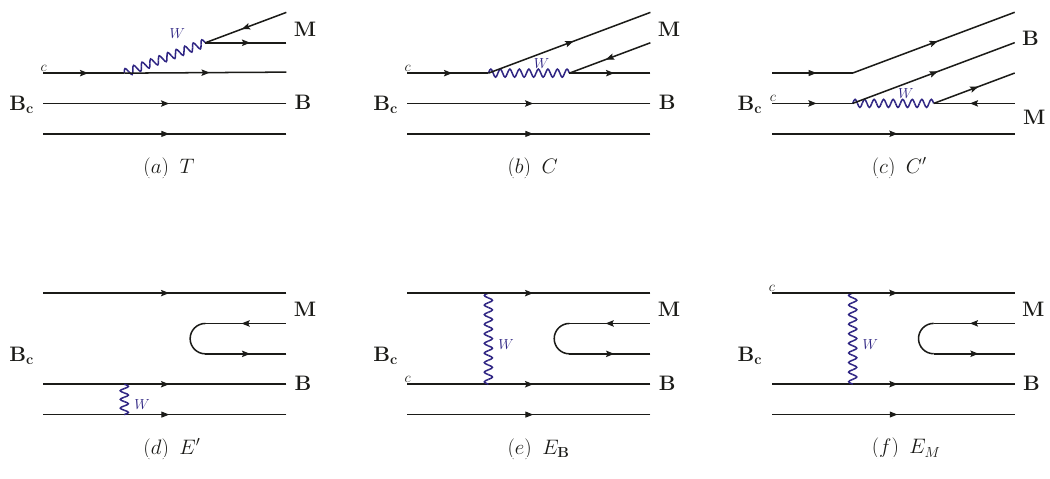
Figure 1 . Topological diagrams for the B c